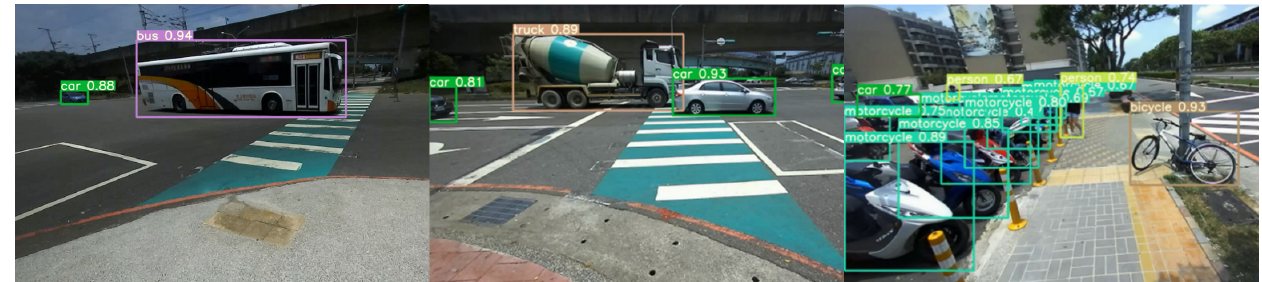
Figure 9. Object detection result by YOLOv5s.